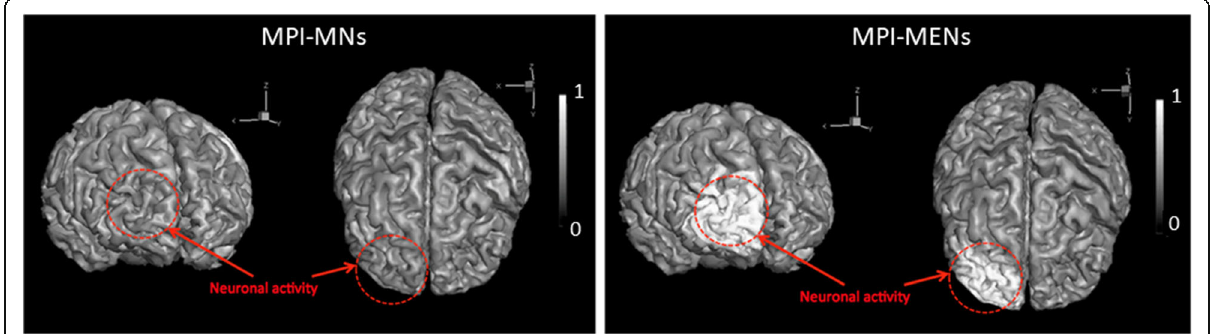
Fig. 3 Normalized MPI images taken with MNs and (right) MENs of two different angle views of the frontal lobes of the cerebral cortex. The region with a simulated neuronal firing is highlighted by the dotted circle